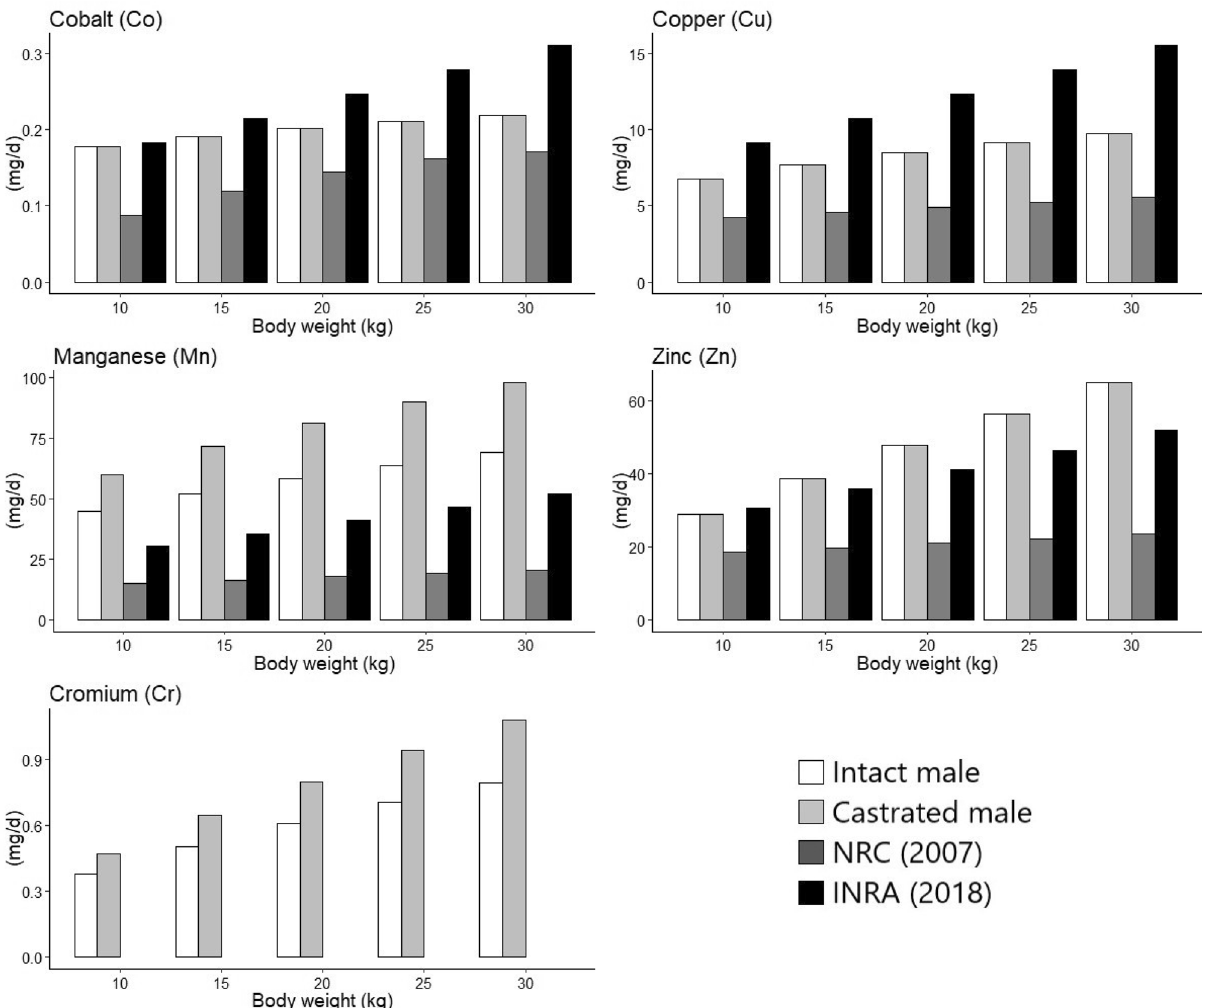
Figure 2. Comparison of total dietary trace mineral requirements among the obtained results and the committees (INRA 6 and NRC 3